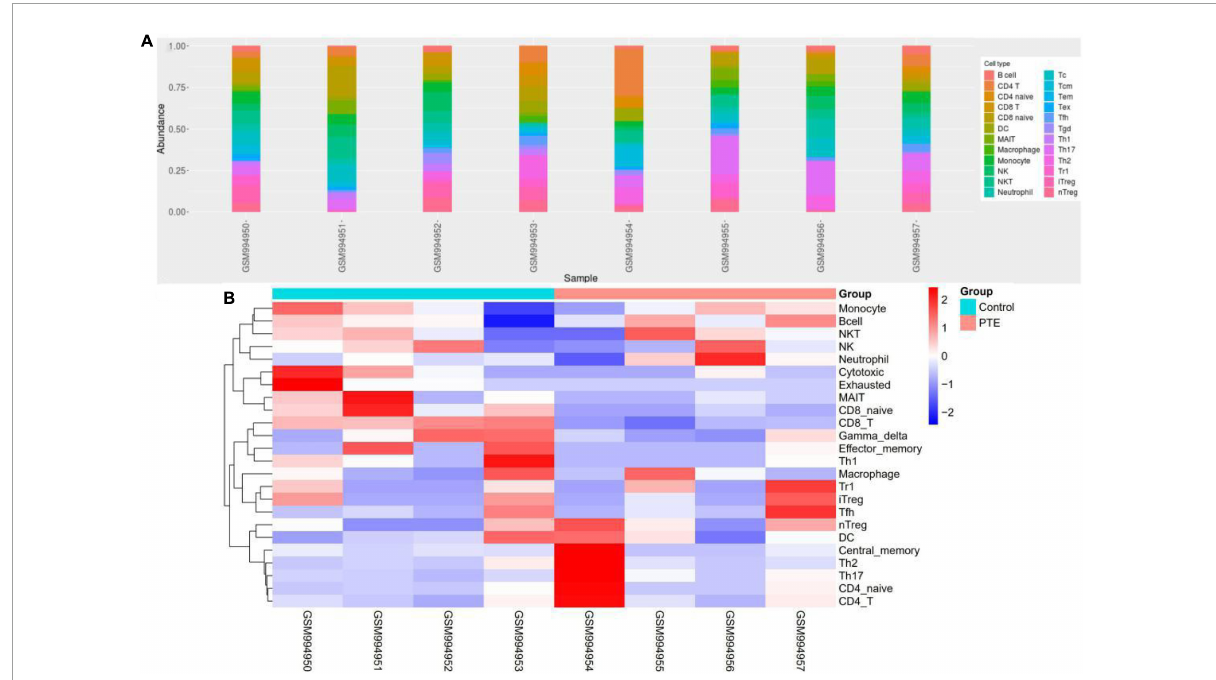
FIGURE6 Immune profile of GSE40490 through ImmuCellAI. (A) Abundance of 24 immune cell types in GSE40490. (B) Differences between the cell types and individual samples.